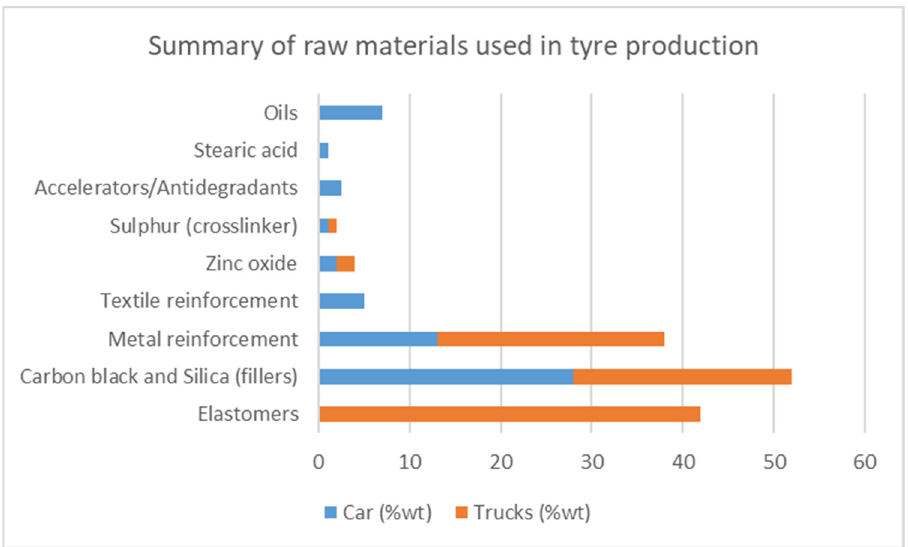
Figure 2. Summary of raw materials in tyre production.